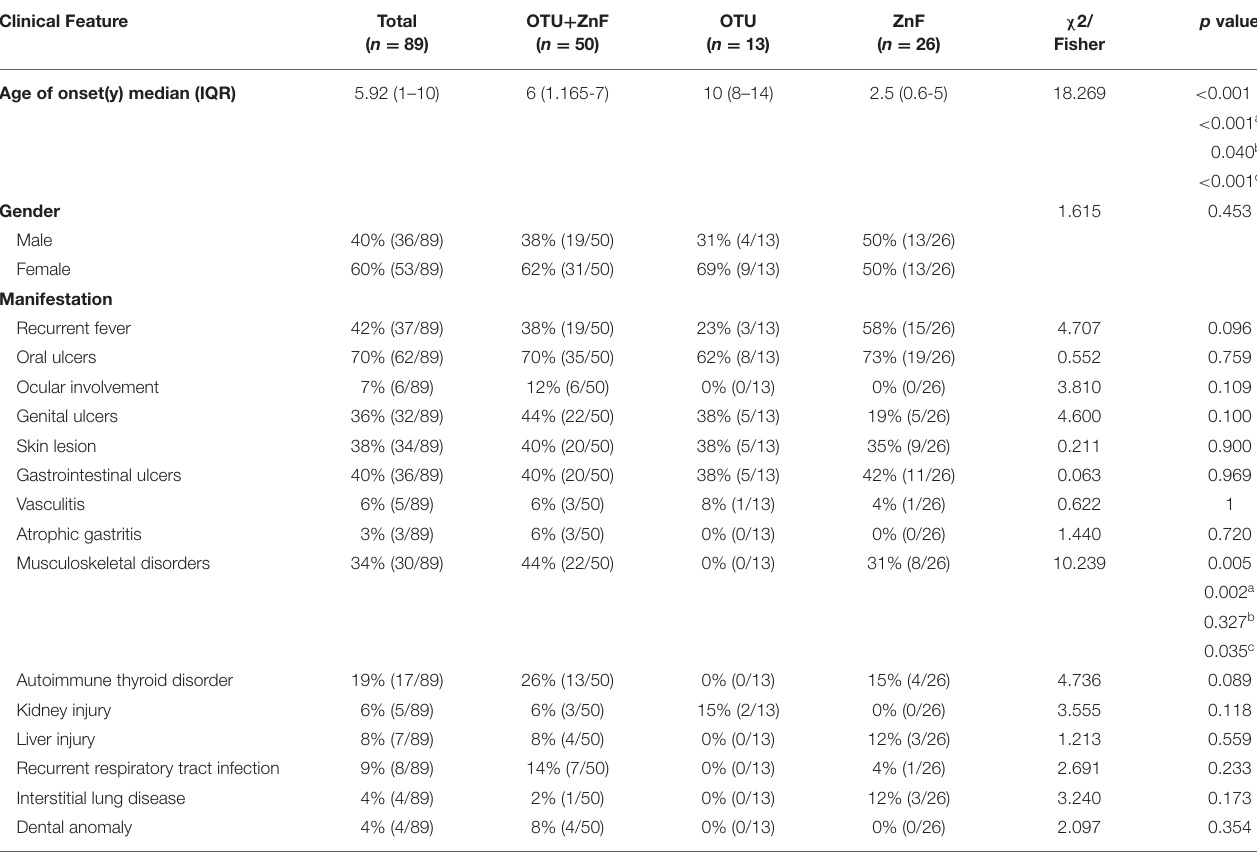
a Comparison of the clinical manifestations between OTU + ZnF and OTU groups. b Comparison of the clinical manifestations between OTU + ZnF and ZnF groups. c Comparison of the clinical manifestations between OTU and ZnF